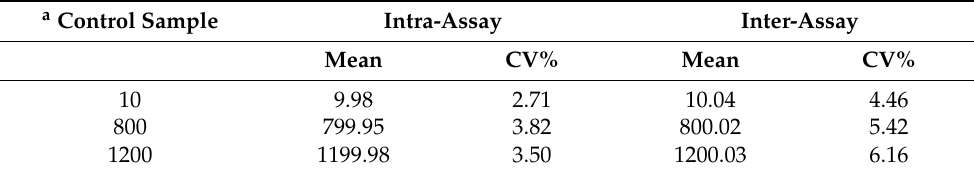
Figure 4. ( A ) Correlation between serial dilution of PSA in 10 mM PBS (pH 7.20) and the current level determined by the method. Each value is the mean of five determinations, and error bars represent standard deviations. ( B ) Correlation between Smartphone FAST-PSA tool platform and commercial ELISA. Table 1. Intra-assay precision (five measurements in the same run for each control sample) and inter-assay precision (five measurements for each control sample, repeated for three consecutive